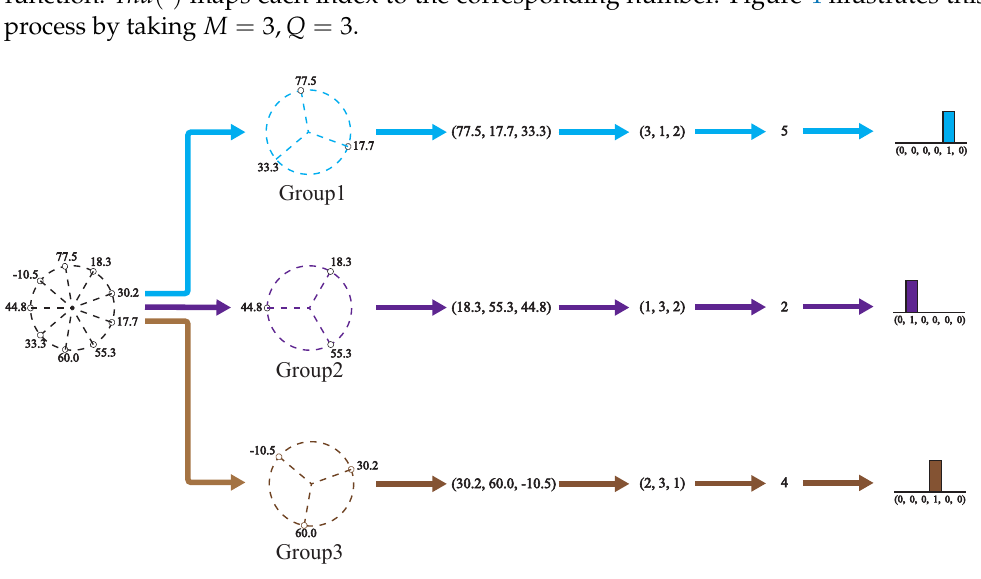
Figure 4. H m ( x i ) Histogram construction